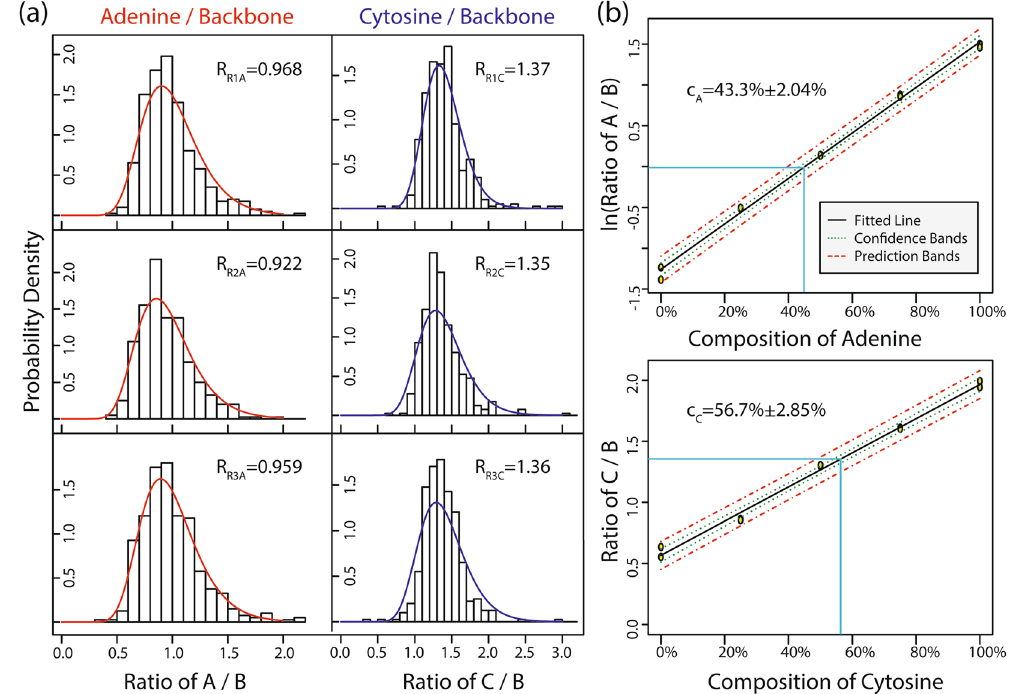
Figure 4. Probability density functions and calibration curve for detection of composition within random ssDNA. ( a ) PDFs of 3 sets of measurements on a random composition of ssDNA with the corresponding lognormal median of each measurement (R). ( b ) Calibration curve based on 2 sets of measurements from each standard (10 total) and the corresponding identification of the composition using the average normalization ratios of the 3 random